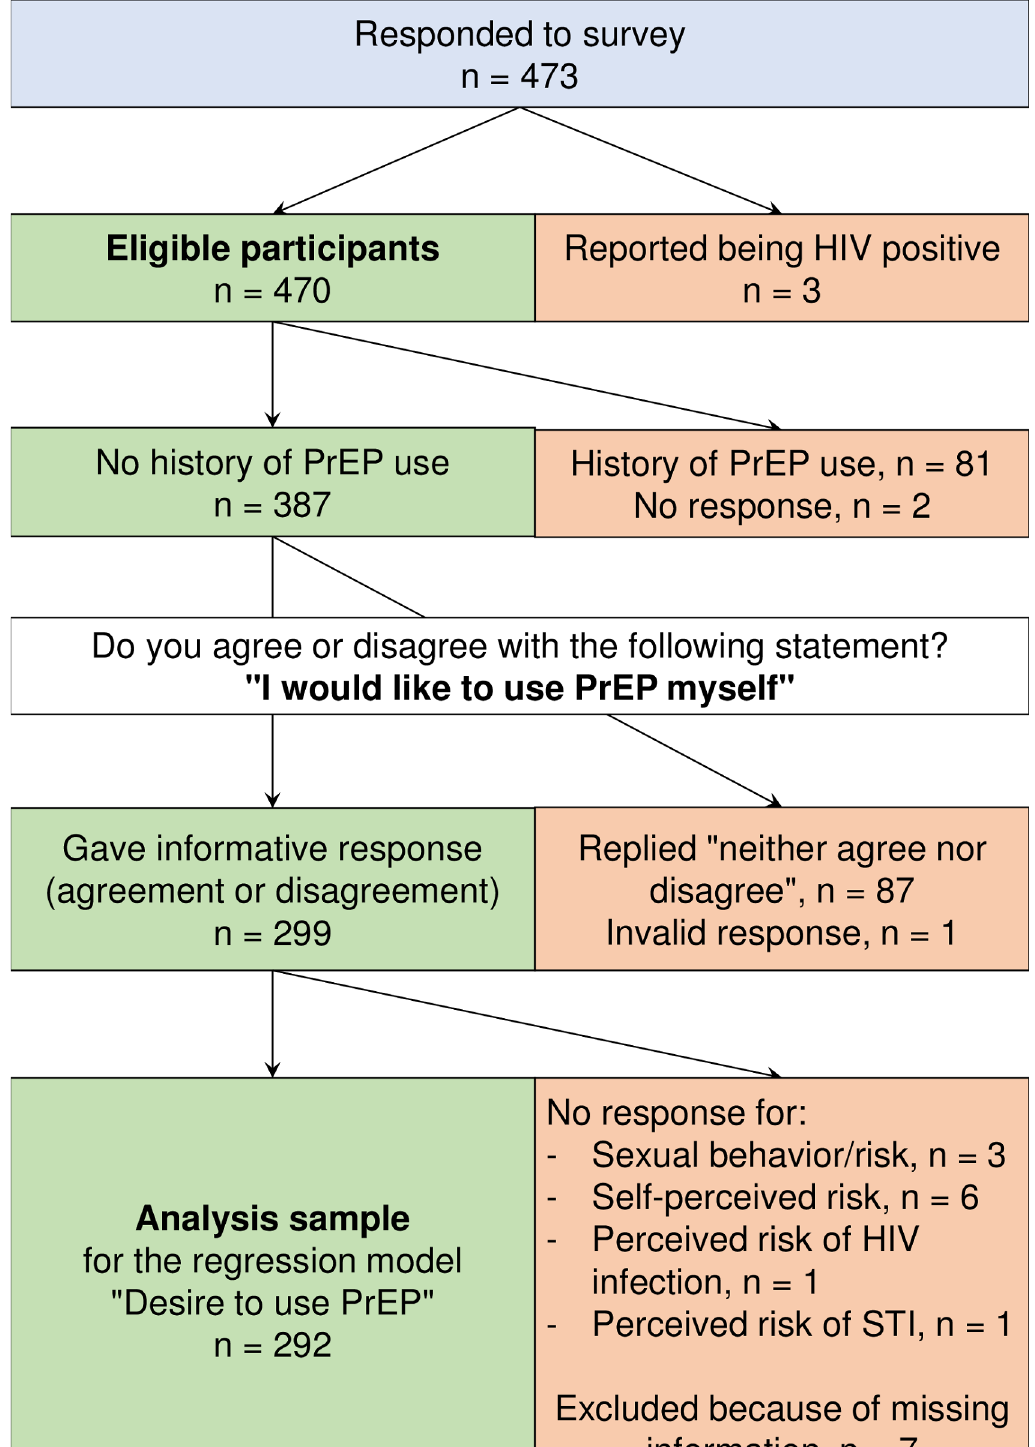
Fig 1. Response tree for the multivariable regression model of desire to use PrEP.